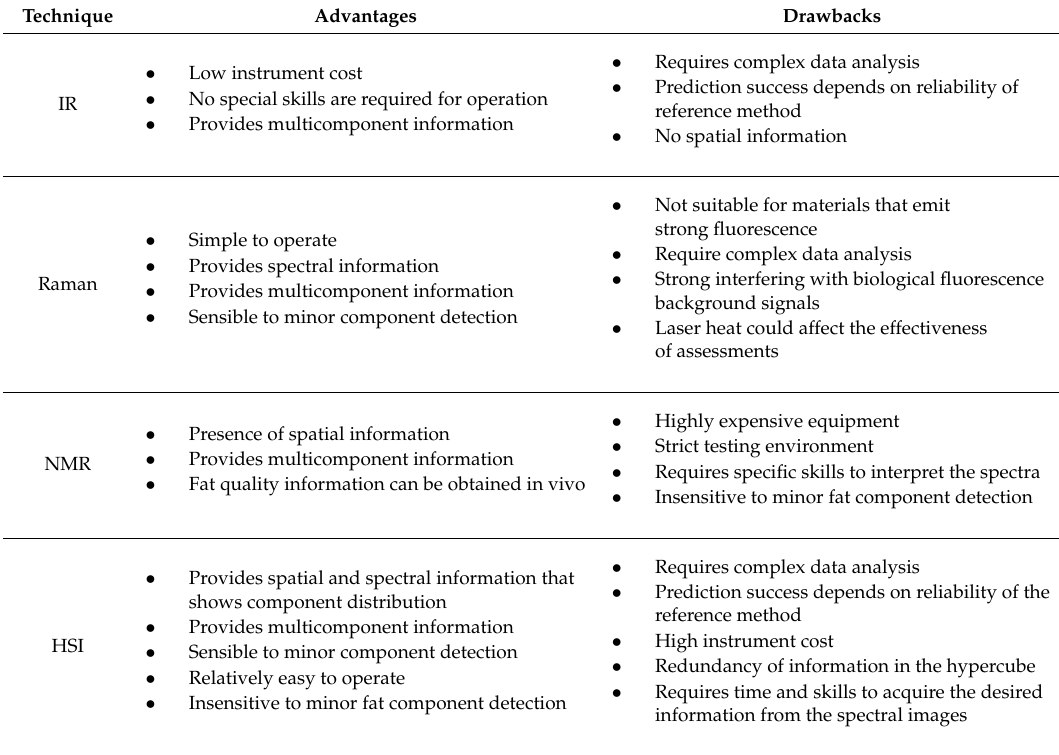
Table 1. Advantage and drawbacks of non-destructive spectroscopic techniques for fat quality